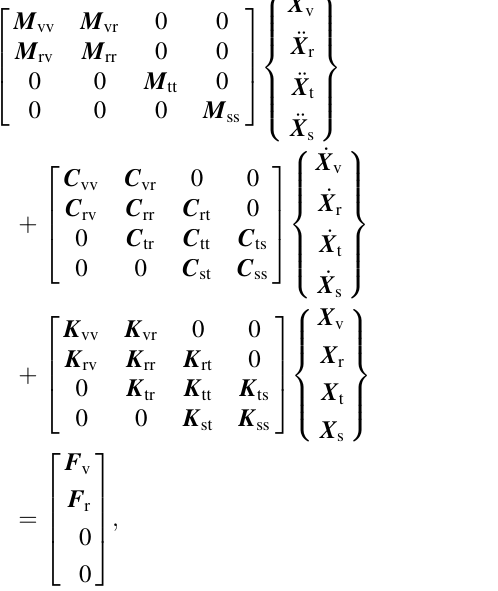
Fig. 1 Vehicle–track–tunnel coupled